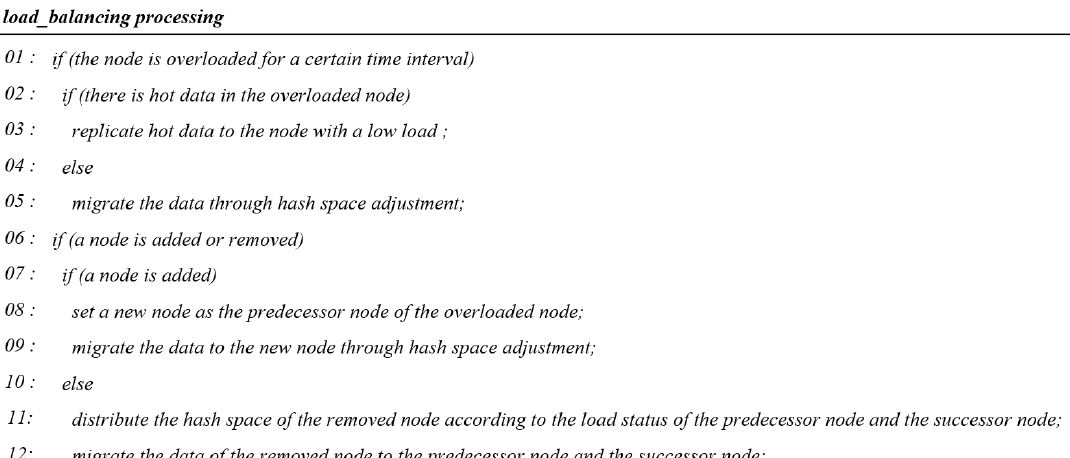
Figure 7. Load balancing processing procedure algorithm.